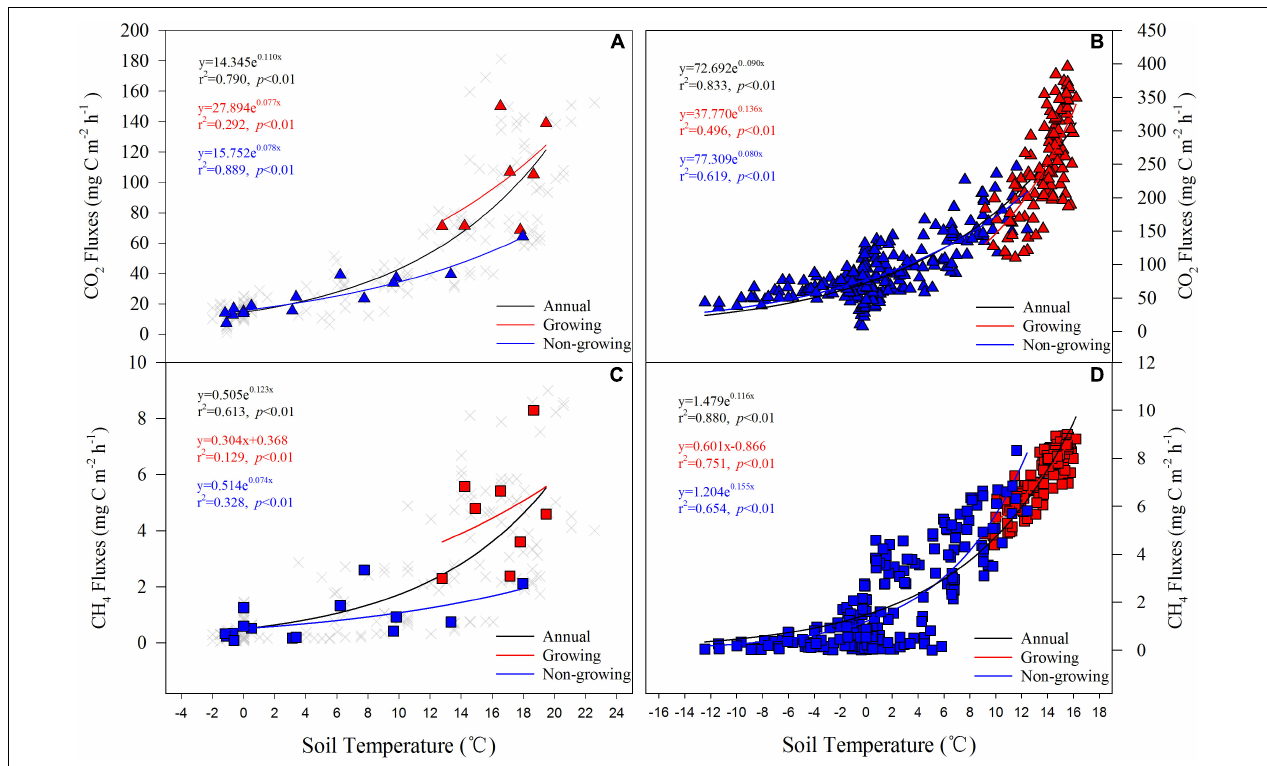
FIGURE 3 | Relationships between GHGs emissions and soil temperatures for annual and growing or non-growing periods, based on linear and non-linear regression. Annual refers data throughout the entire year; Growing , data in the growing season (May-Sep); Non-growing , data in the non-growing season (Jan-Apr and Oct-Dec). Data were collected using thestatic chamber (A,C) or eddy covariance (EC) method (B,D)